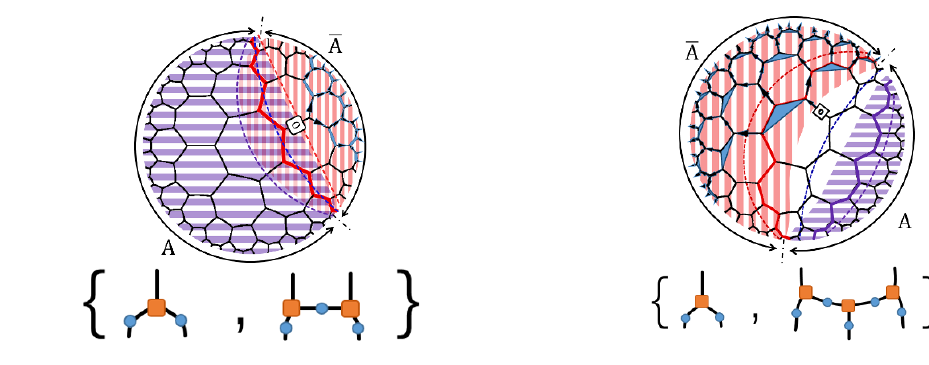
Figure 13 . The tensor network with f 7 ; 3 g tiling nh 1 i h 1 0 1 io and S c = ; . An operator is pushed 2 1 1 1 to the boundary. The CP region is enclosed by two CP curves.